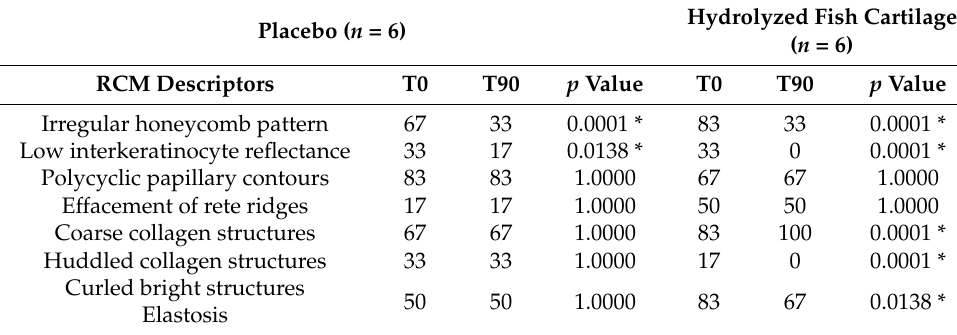
Table 2. Reflectance confocal microscopy (RCM) descriptors of photoaged skin.